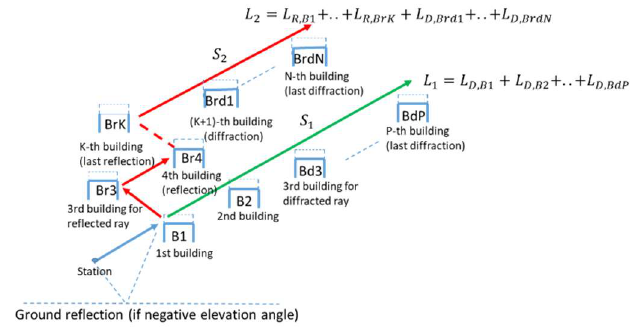
Figure 10. Clutter loss calculation for a sample NLoS scenario.